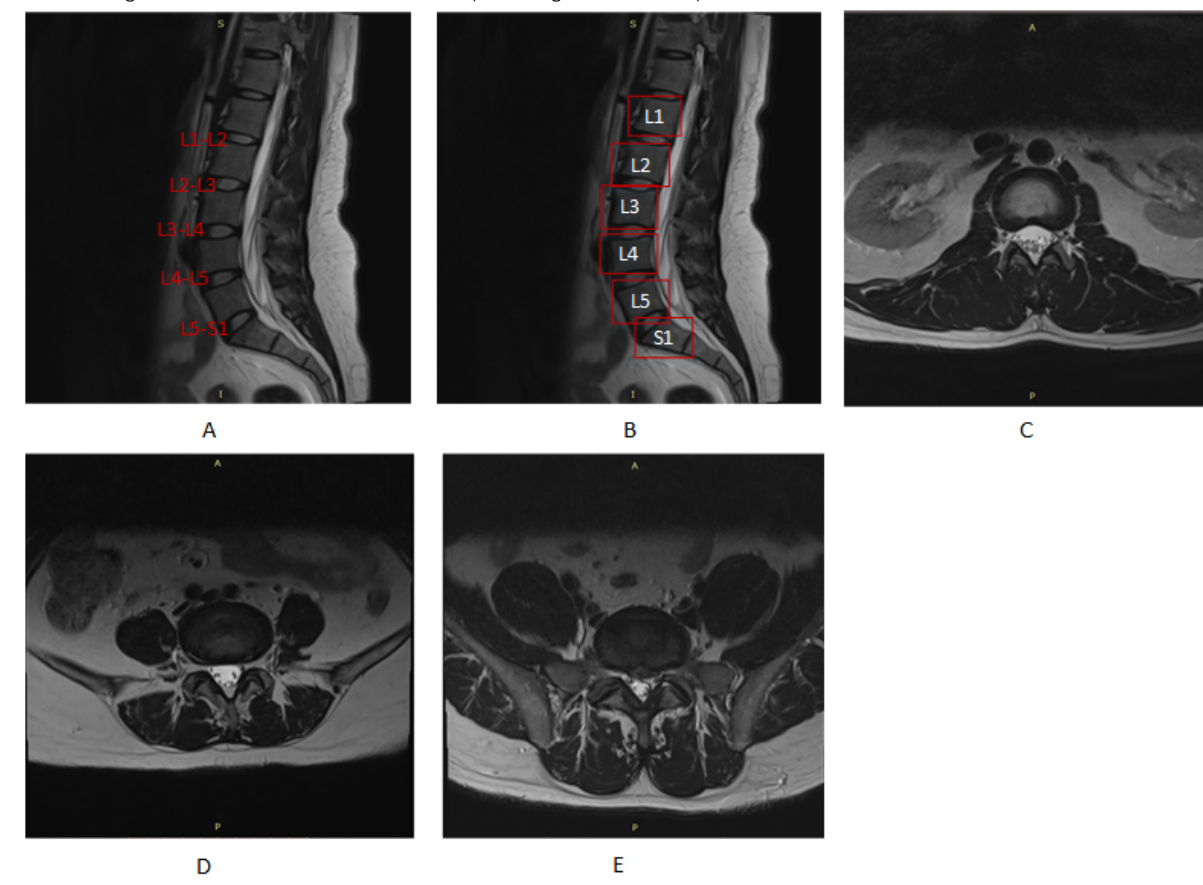
Figure 1. Examples of lumbar MR images. (A) A sagittal lumbar MR image in which 5 IVDs are labeled. (B) A sagittal lumbar MR image in which 6 vertebral bodies are enclosed in boxes. (C) An axial lumbar MR image of a normal disk. (D) An axial lumbar MR image of disk bulge. (E) An axial lumbar MR image of disk herniation. L: lumbar vertebra; MR: magnetic resonance; S: